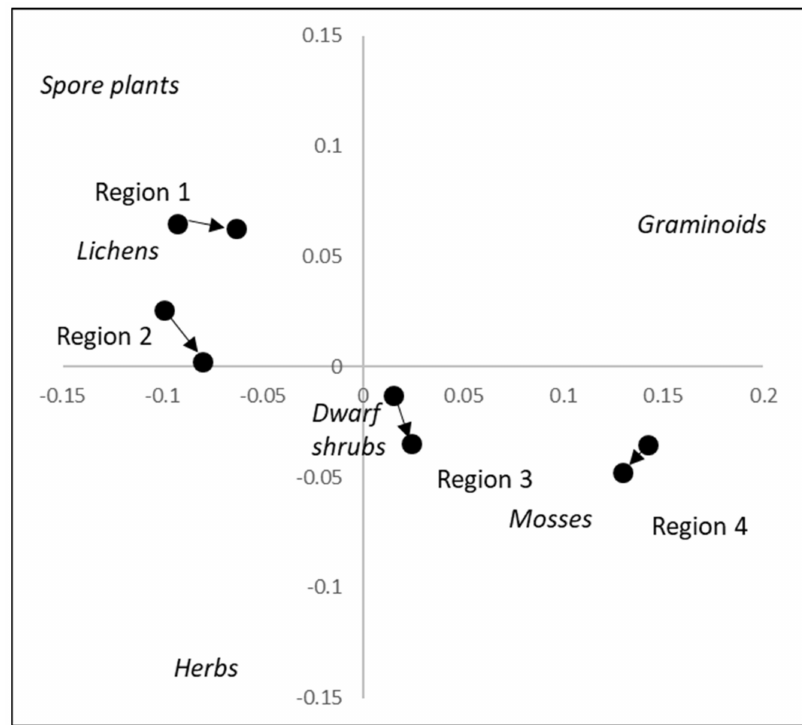
Figure A1. NMDS ordination (dimensions 3 and 4) of the six different species groups where markers provide the average “sites scores” for the four different regions at the two inventories. Arrows denote the direction of change. Note that, to increase the readability of the figure, the placement of the species group scores is not representing their actual scores since these are outside the current axes. However, their relative position indicates where they occur in the ordination. The difference between regions remains clear also along the NMDS 3 and 4 axes, while the change between periods is